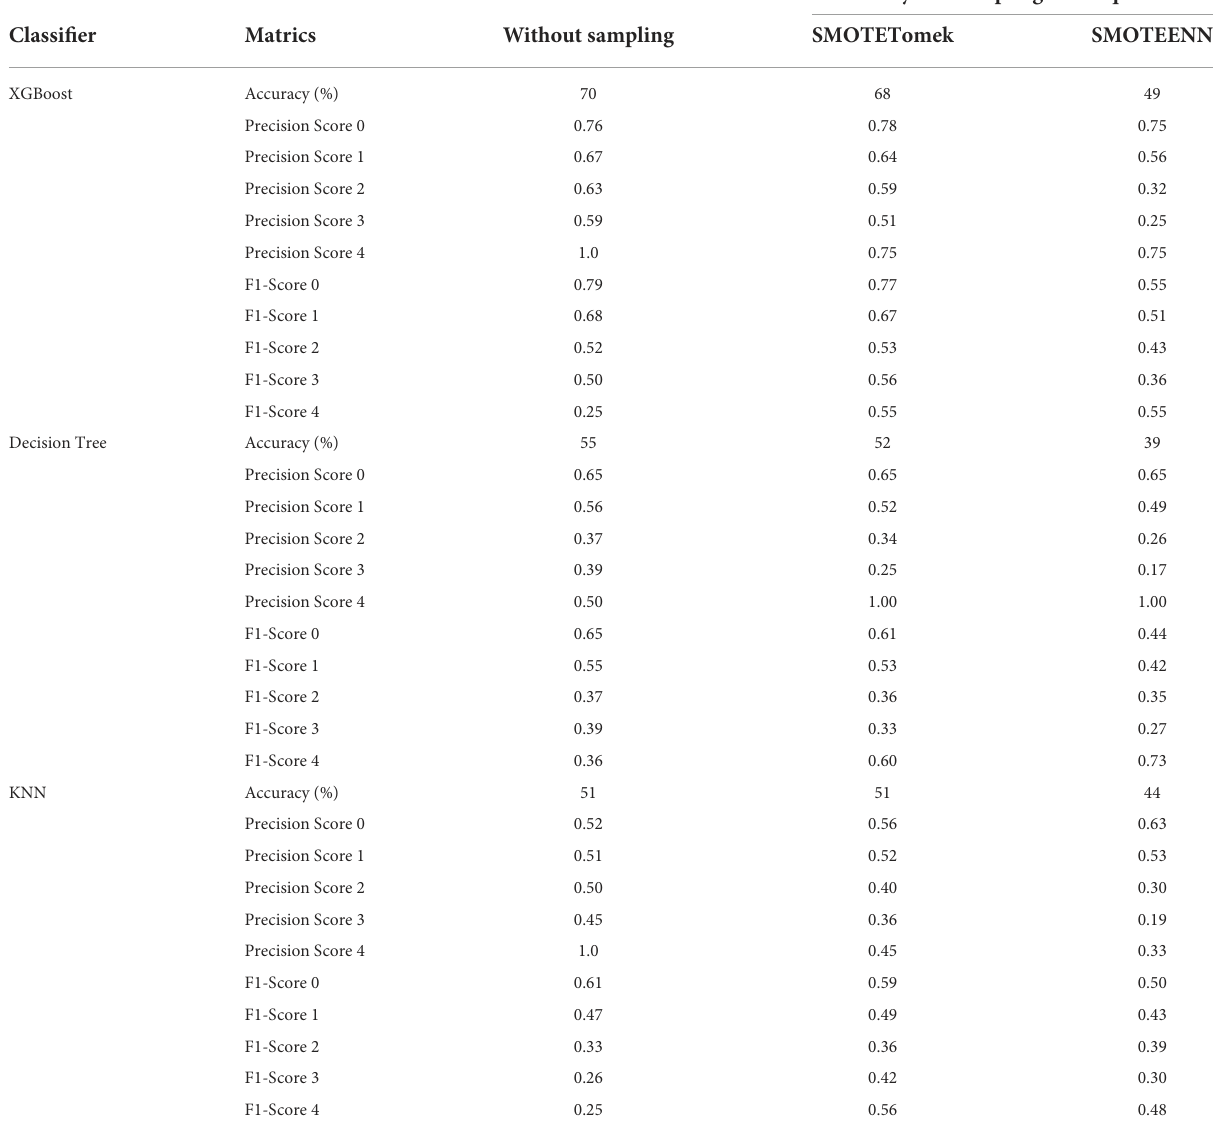
Hybrid sampling